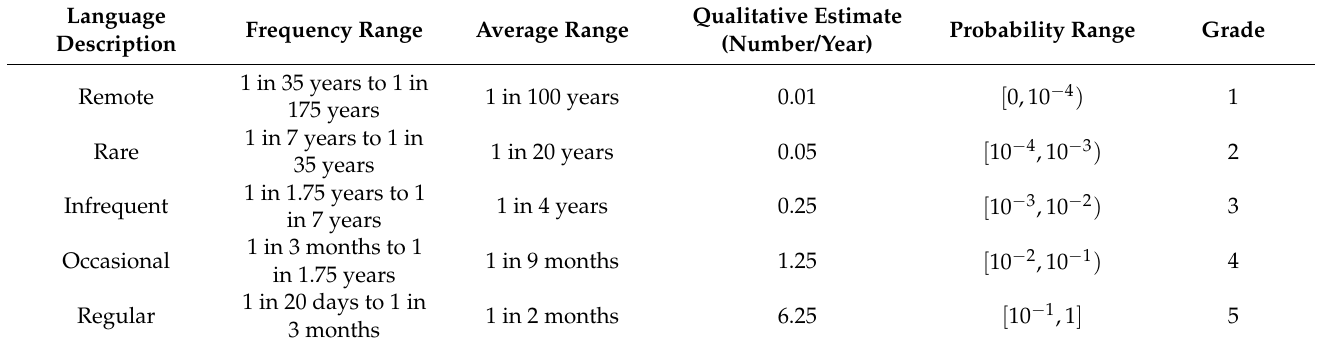
Table 5. Safety behavior risk probability rating standard of the train operation department.